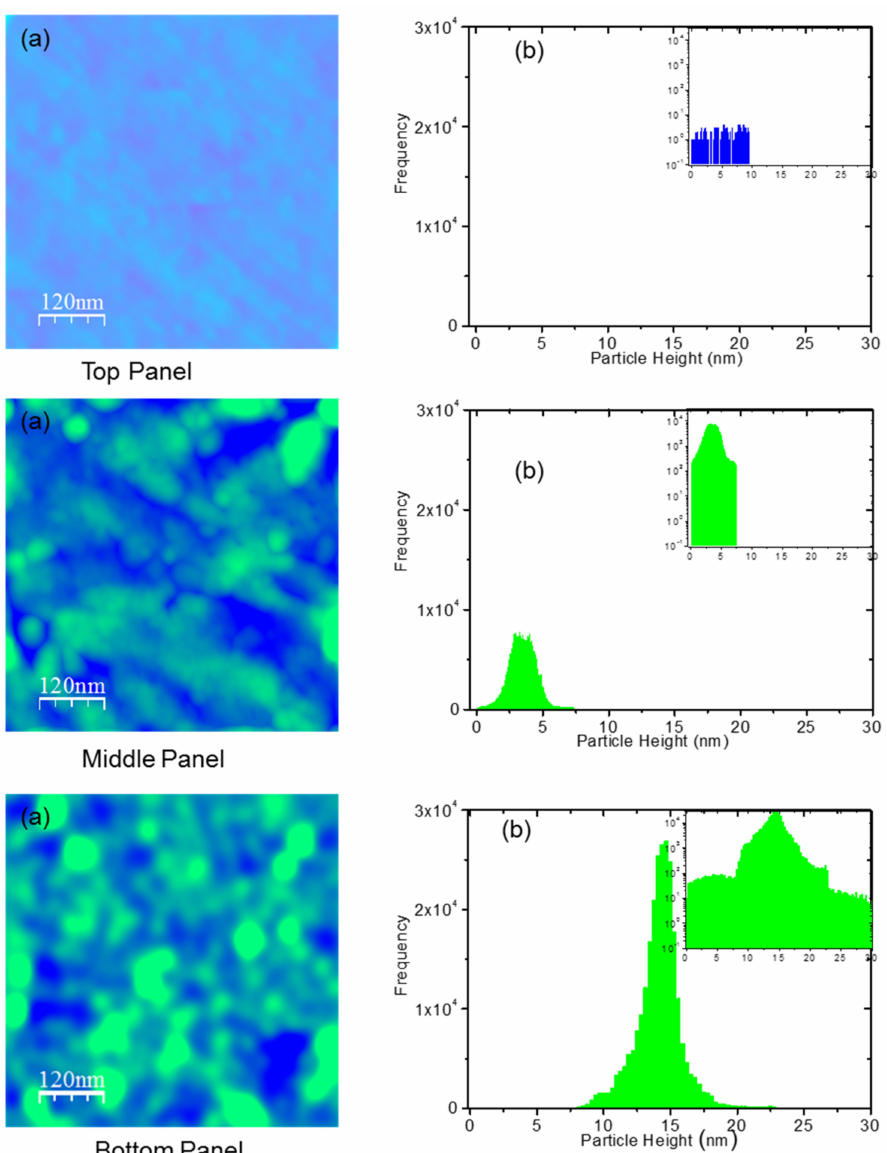
Figure 2. Top-left panel ( a ), high resolution TM-AFM image of a control (colchicine untreated) cell surface. Top-right panel ( b ), histograms presented here are based on counted clusters on the section of cell surface shown in the left panel ( a ). Each histogram represents the number of counted clusters (called frequency, let us assume it as f i , plotted along y-axis. i = 1, 2, 3, . . . , etc.) versus a height profile (known as particle height, Figure 2b (top-right panel), let us assume it as h i , plotted in nm scale along x-axis) shown in Figure 2b. As mentioned in Supplementary Figure S5, the height profiles are recorded at the centers of the corresponding clusters (see the left panel), Figure 2a. Middle and bottom panels present data for cells treated with 1 and 100 µ M colchicine, respectively. The higher presence of clusters (in green color) on blue background is visible. We repeated the experiments three times but inspected no substantial changes in the distribution patterns presented in the right panels. Origin 9.1 was used to plot histograms after detecting the numbers using program WSxM. The origin of the detected few events (visible in log plots, see in insets of Figure 2b) for untreated/control cell surface is nothing but